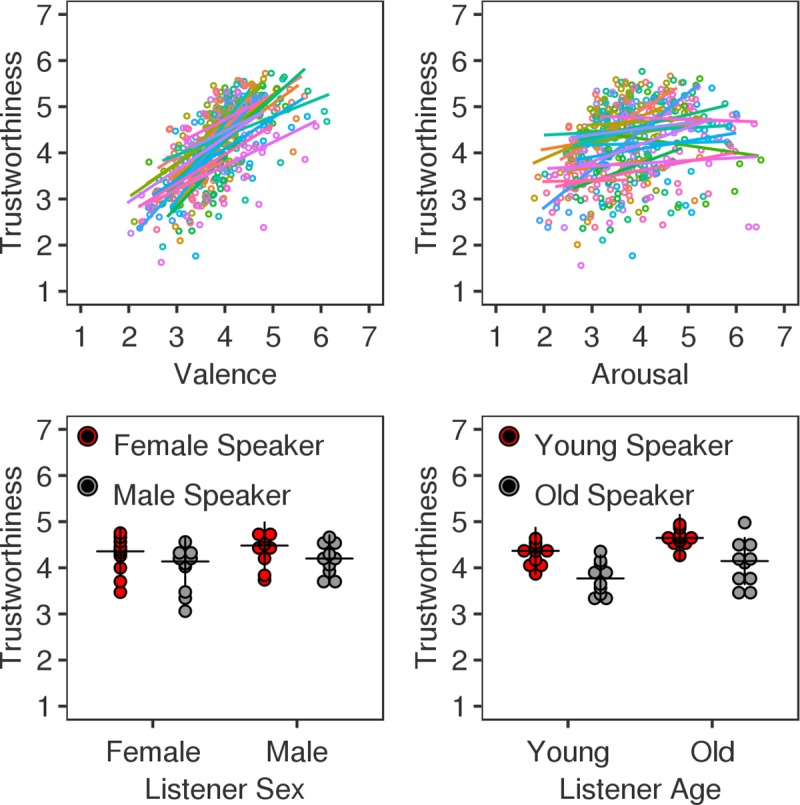
Trustworthiness rating results.Top row—The scatter plots illustrate the relation between valence and trustworthiness (left) and arousal and trustworthiness (right). Colours represent individual speakers (N = 20) in a consistent manner across the two graphs. Data points reflect trustworthiness averages for each expression and sentence computed across listeners and are summarized with a regression line. Bottom row–Plots illustrating the interaction of speaker and listener characteristics for sex (left) and age (right), respectively. Female and younger speakers are represented by red dots, whereas male and older speakers are represented by grey dots. Data points reflect trustworthiness averages for individual speakers computed across expressions, sentences and listeners. Median values are marked by a black cross.